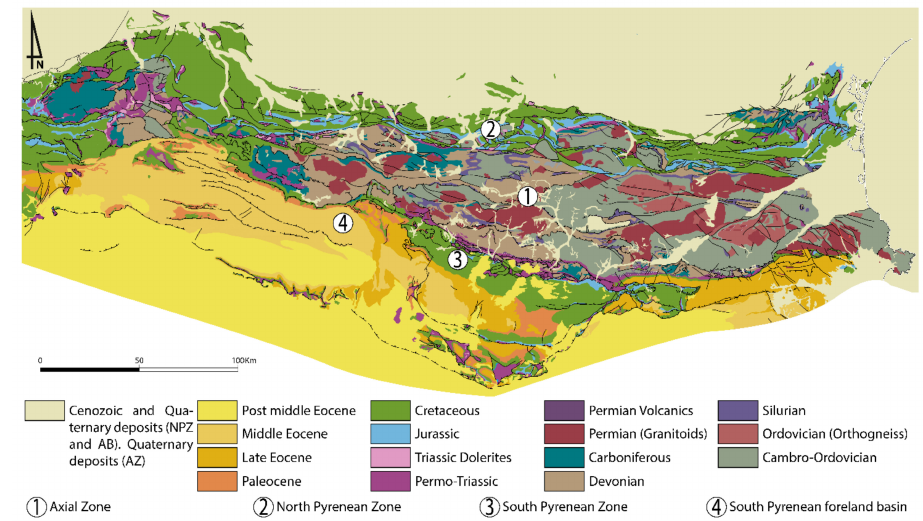
Figure 2. GeologicalmapofthecentralPyrenees(modifiedfromasynthesisbyRodr í guez-Fern á ndezetal.[107]) showing the potential source rock terrains for the late Eocene–Oligocene systems of the Jaca basin. Dark frame represents the location of the study area. AB: Aquitanian basin; NPZ: North Pyrenean Zone; AZ: Axial